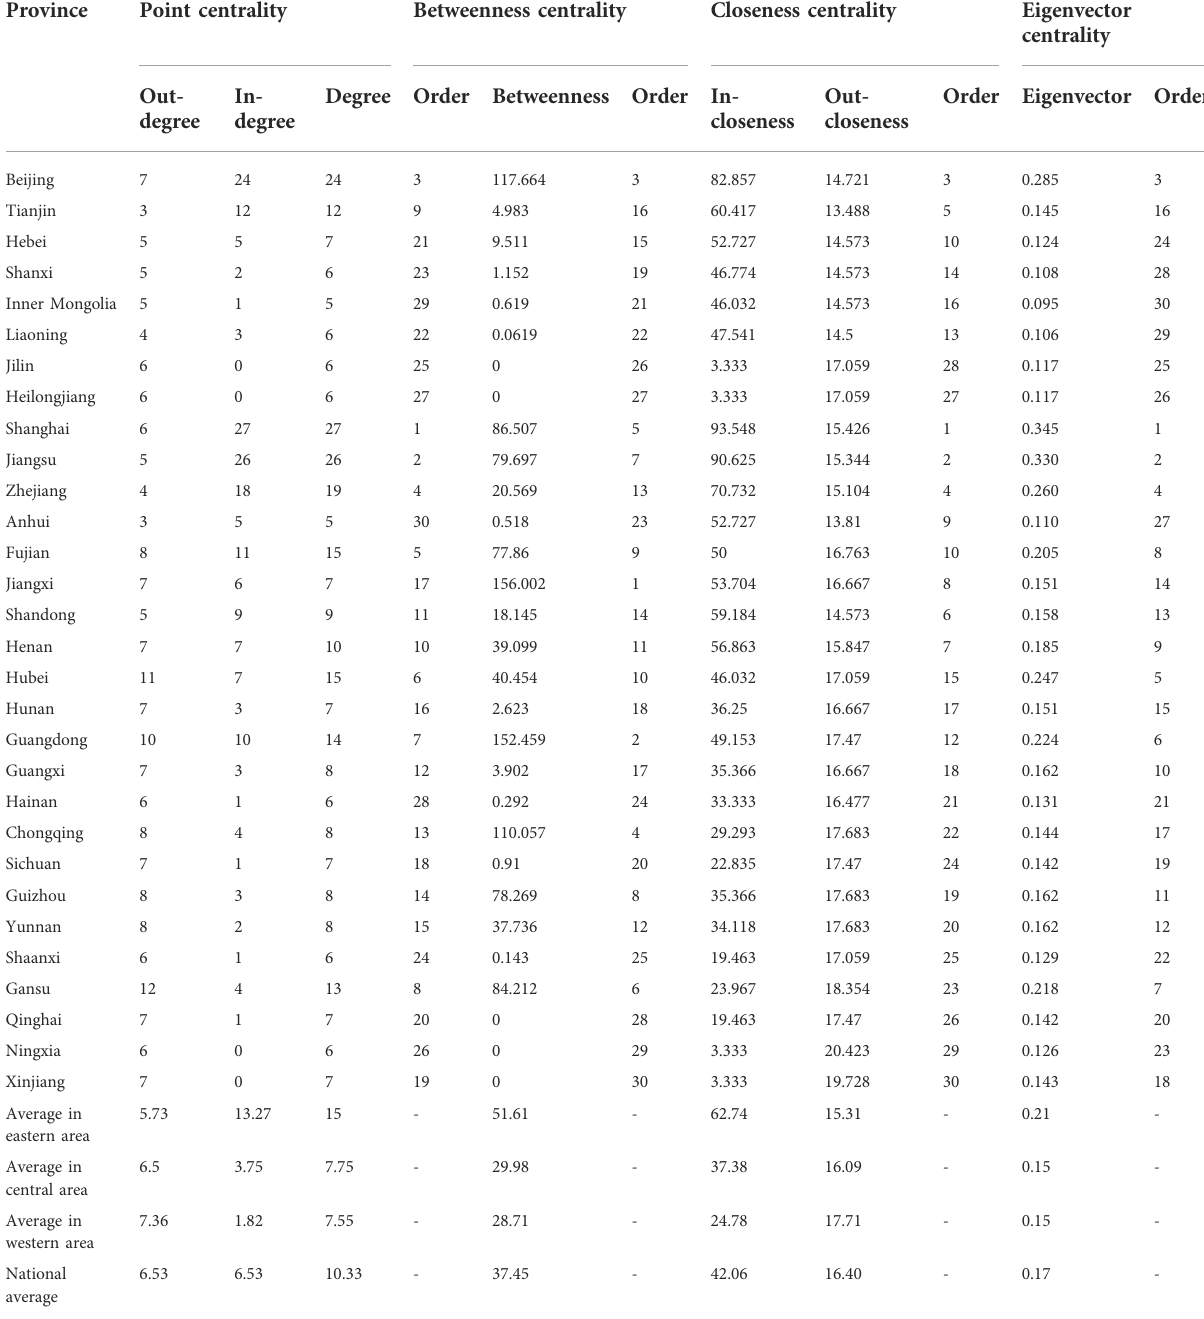
TABLE 4 The centrality analysis of the GTFP in